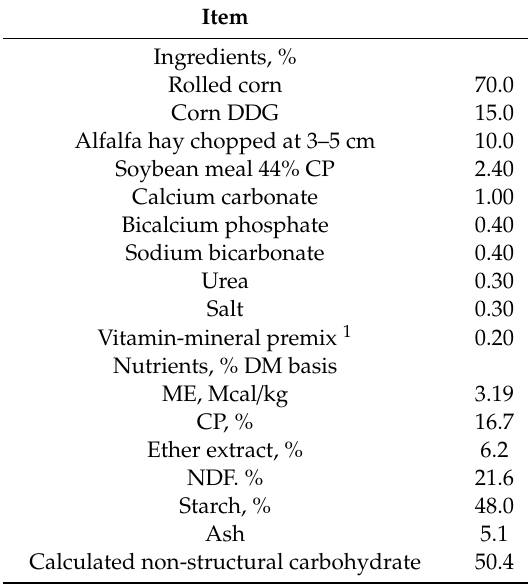
Table 1. Ingredient and nutrient composition of total mixed ration (TMR). Item Ingredients,